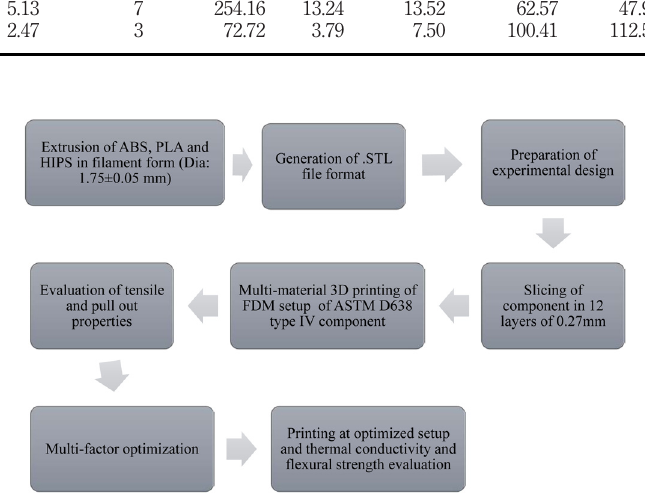
Table I. Mechanical, thermal and rheological properties of ABS, PLA and